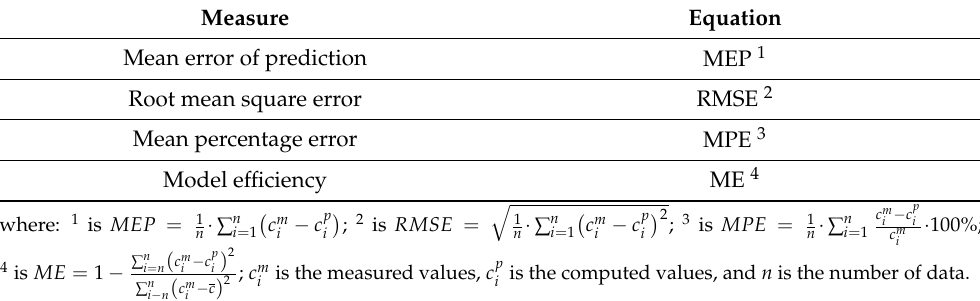
Table 3. Measures of model performance